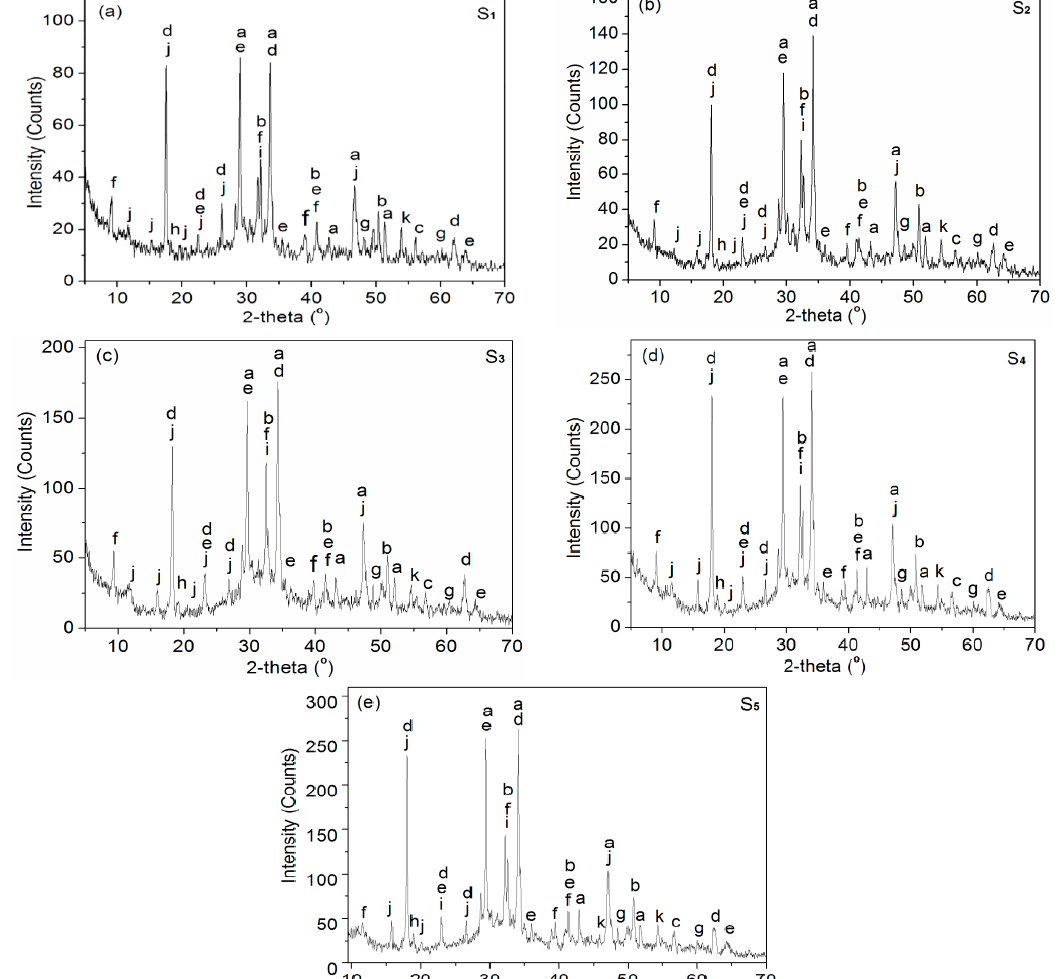
Figure 13. XRD patterns of cement composites at 28 day. ( a ) S 1 sample; ( b ) S 2 sample; ( c ) S 3 sample;